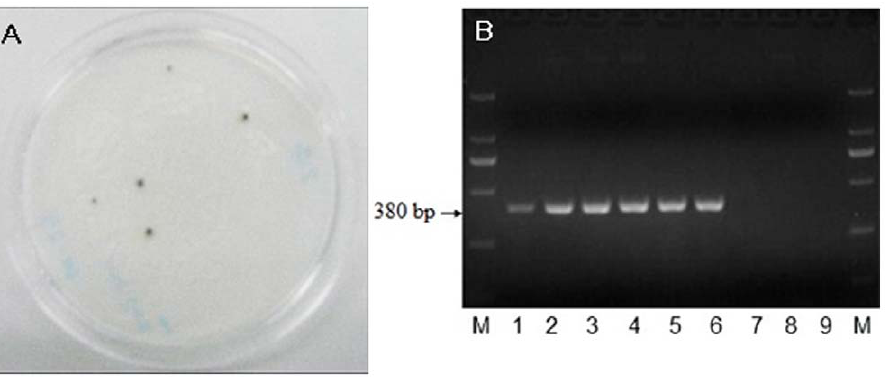
Figure 2. Growth of transformants MT-Bs on the TAP media with 3 m g/mL Zeomycin (A) and PCR analysis with B1/B2 primers (B). M, DL2000 marker; lanes1-6, different clones of MT-B; lanes 7–8, negative controls CC-2654 and CC-124; lane 9, water used as negative control.